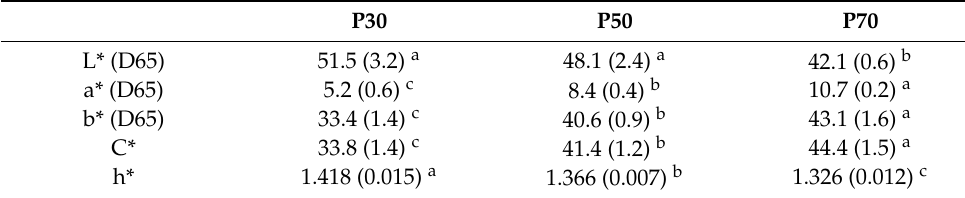
Table 4. Color parameters L*, a*, b*, C*, and h* of apricot gel samples.